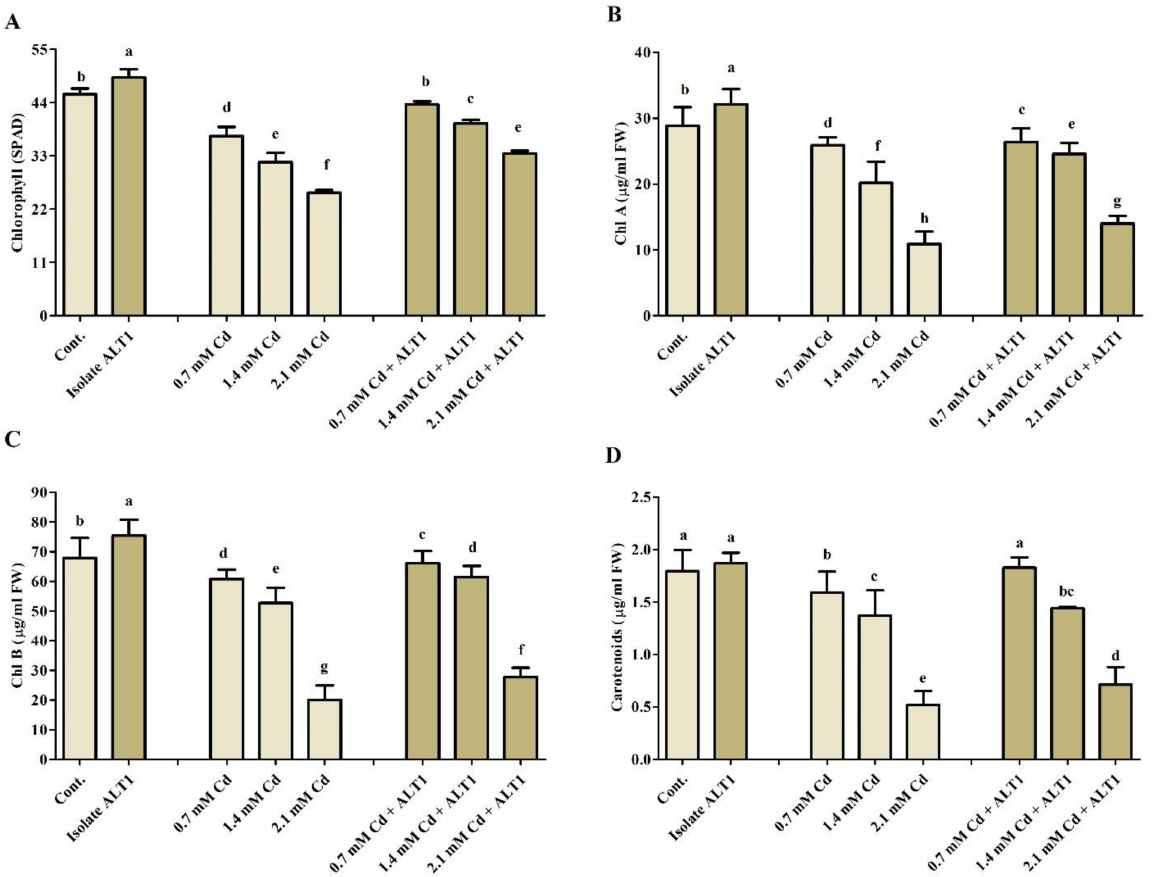
Figure 2. Effect of Cd stress on chlorophyll content of ALT1-inoculated and non-inoculated soybean plants. ( A ): chlorophyll content (SPAD); ( B ): chlorophyll a (chl a ); ( C ): chlorophyll b (chl b ); ( D ): carotenoids’ content. Each data point is the mean of three replications and error bars represent standard errors. The bars with different letters are significantly different from each other as evaluated by Duncan’s multiple range